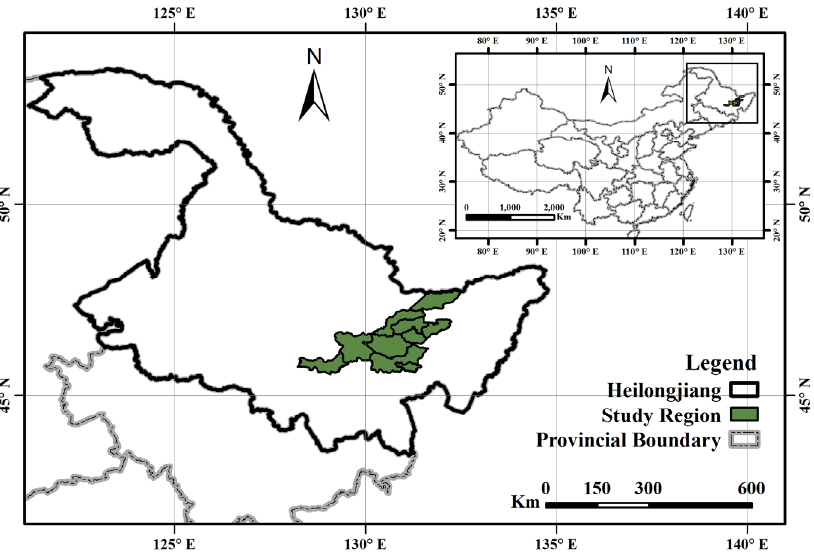
Figure 1. Study site in Heilongjiang, northeast China.